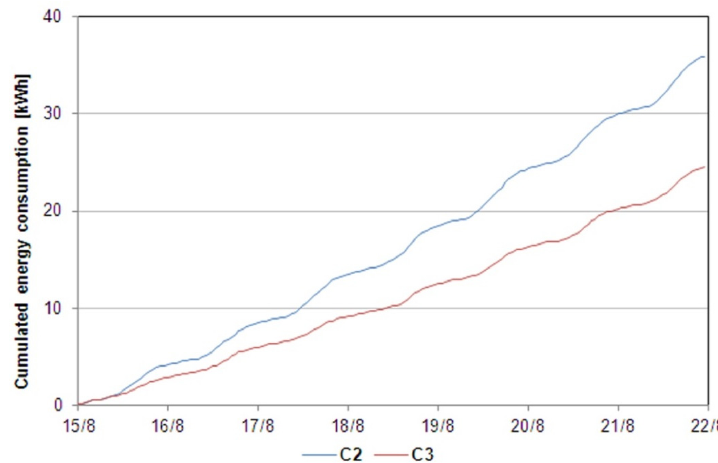
Figure 11. Energy consumption referring to the operation of the ventilated window alone, in summer.